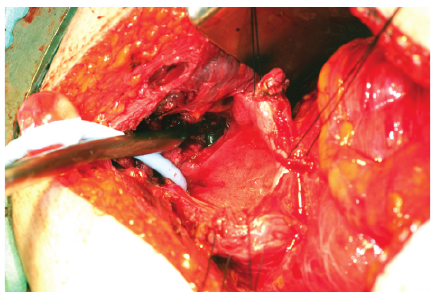
Figure 6: Open bladder after bone spur